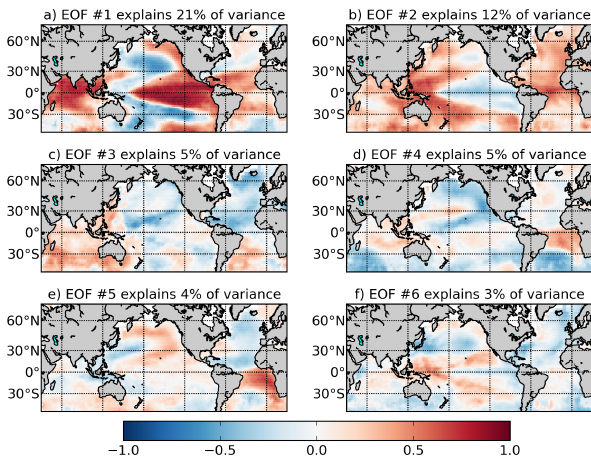
Fig. 3. First six EOFs determined for the same data set as used to Fig. 3: First six EOFs determined for the same dataset as used to build the H-SST network. build the H-SST